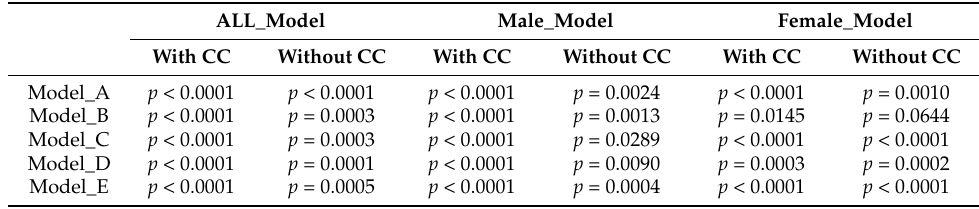
Table 4. Results of the Shapiro–Wilk